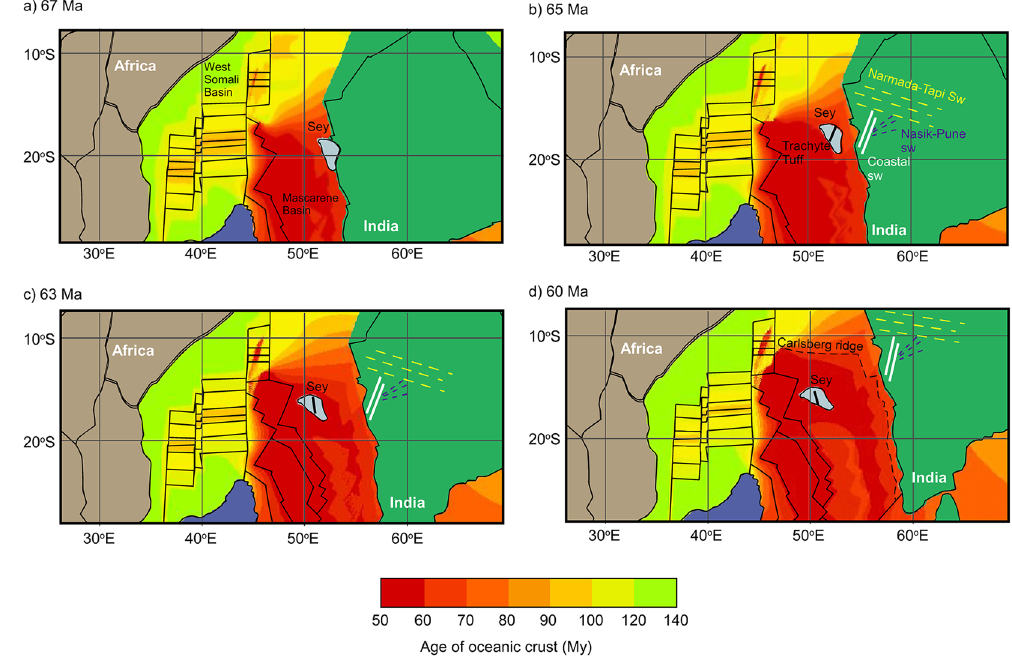
Figure 3. Reconstructed tectonic evolution of Seychelles micro-continent during Early Palæogene via GPlates 1.5 software https://sourceforge.net/projects/gplates/files/gplates/1.5/ and the sample source data provided by Earthbyte for paleotectonic evolution https://www.earthbyte.org/gplates-1-5-software-and-data-sets/, and oceanic crust evolution https://www.earthbyte.org/age-spreading-rates-and-spreading-asymmetry-of-the- worlds-ocean-crust/. ( a ) Paleo-position of the Seychelles microcontinent next to western India at 67 Ma. ( b ) Rifting of the Seychelles from India. The paleo-orientation of trachyte tuff is parallel to the Coastal swarm around 65 Ma. ( c ) Continuous rifting and anticlockwise rotating of Seychelles around 63 Ma. ( d ) Cessation of Seychelles rotation around 60 Ma. The color bar marks the age of oceanic crust. The thin black lines marked the ridges within the West Somali basin and the Mascarene